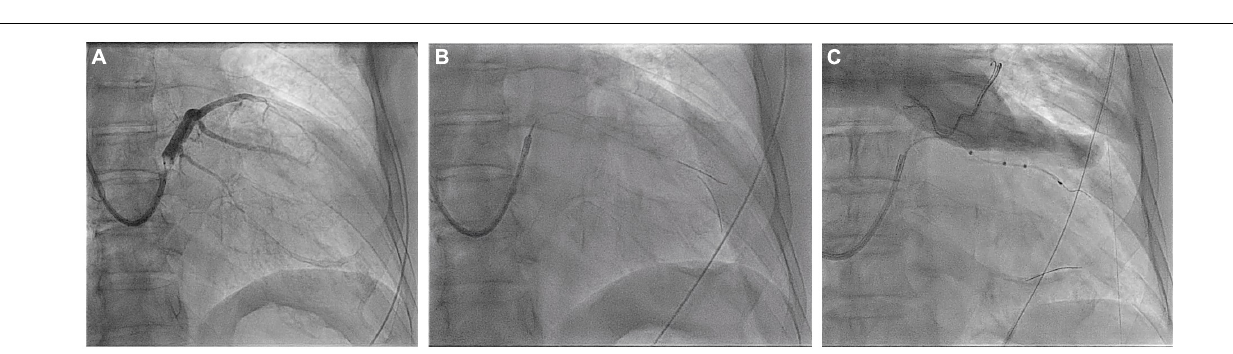
to double-wire the acute take-off vein. As described by Chierchia (7), two 0.014 (cid:48)(cid:48) runthrough-NS floppy guidewires (Terumo)